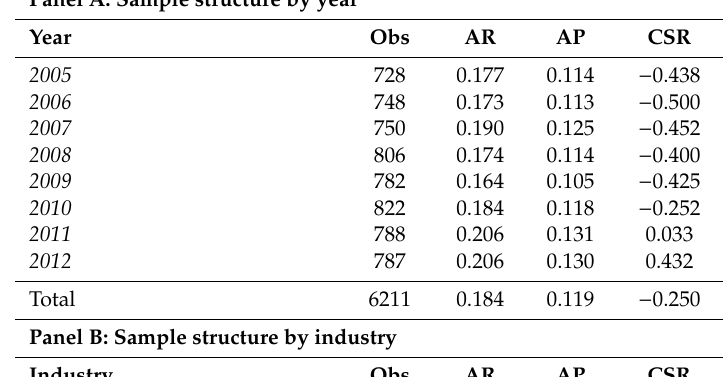
Table 1. Sample structure of dependent and independent variables by year and industry. Panel A: Sample structure by